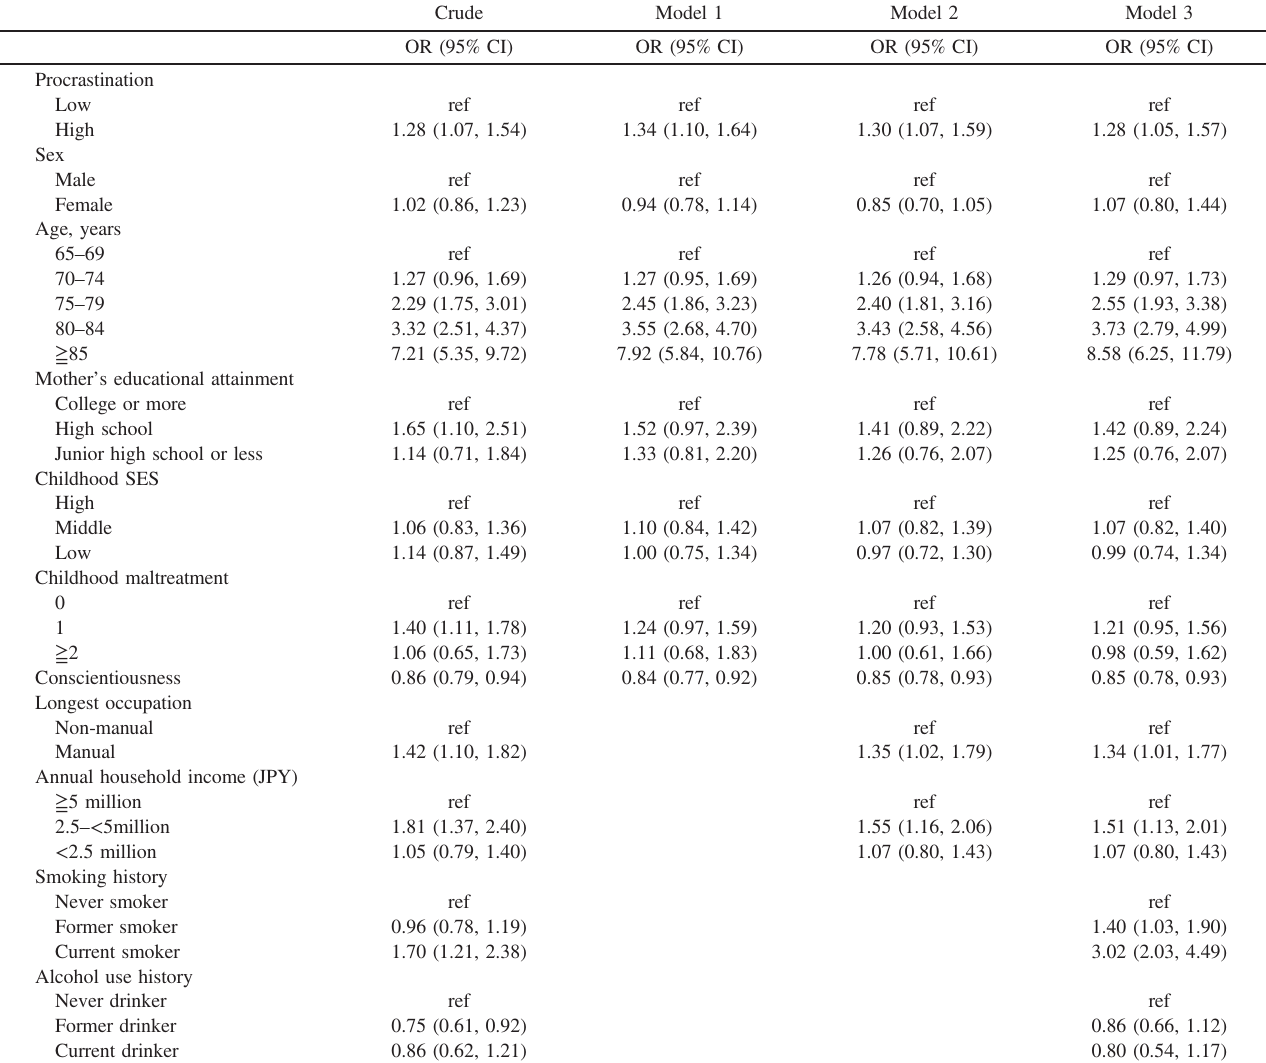
Table 2. ORs and 95% CIs for having fewer remaining teeth ( N = 1,616)